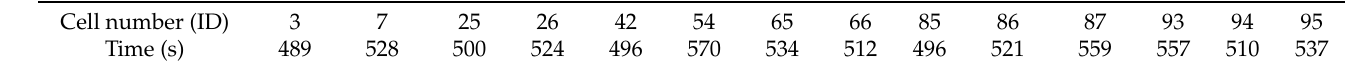
Table 4. Indexes of cells with below-average voltage.